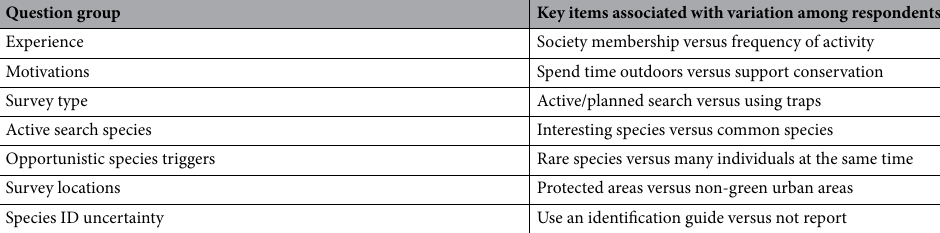
Table 2. Items explaining variation among people, as assessed by which items loaded most strongly onto each of the first two principal components of a PCA. Figure S8 shows the PCA biplots for each question group and Table S1 lists all items within each question group.